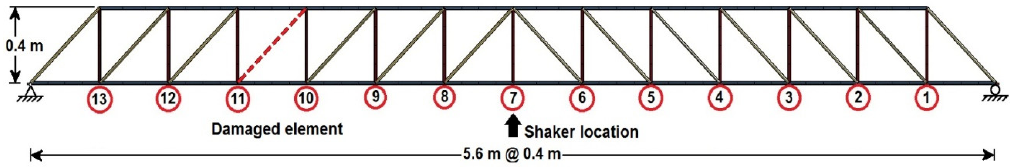
Figure 3. A schematic view of the truss bridge model by showing the uniform distribution of the locations of sensors, and the location of the damaged element.